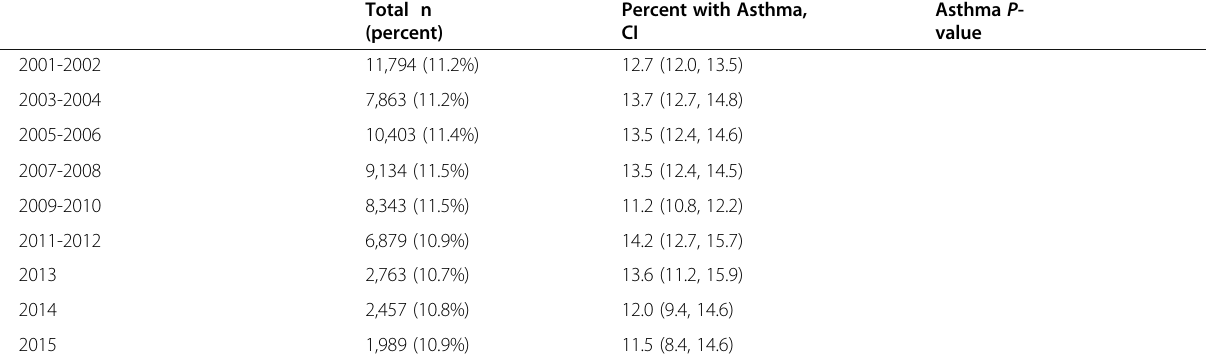
Estimated annual population of children = 5,697,515. Those with asthma = 733,320. Sample numbers are unweighted, all percents are survey-weighted CI 95% Confidence Interval * p <0.05, ** p <0.01, *** p